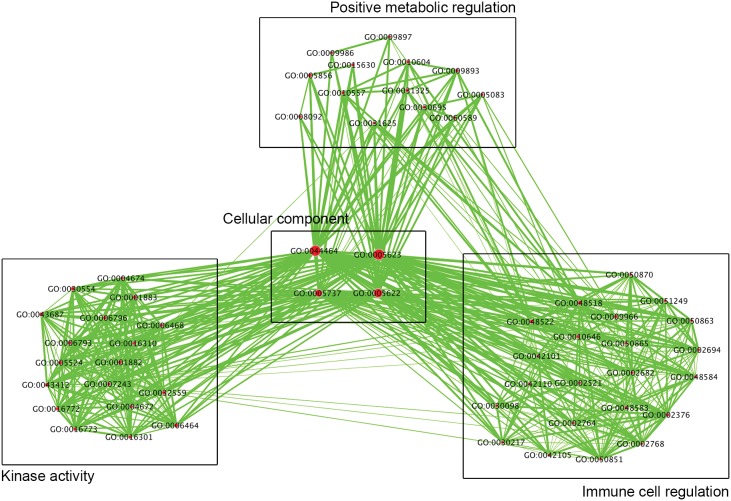
Clustering of DAVID GO results.Network map showing the clustering of DAVID GO results as produced by the Enrichment Map plugin in Cytoscape 2.8.2. Significant GO term clusters were named according to textual attributes generated by the WordCloud plugin. Node size (red circles) corresponds to the number of genes within the GO terms. Edge thickness (green lines) represents genes in common between GO terms.